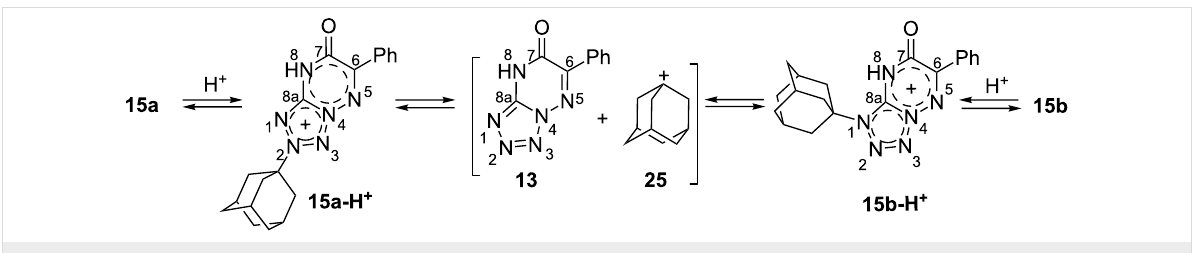
Scheme 5: Mechanism of the isomerization of compounds 15a and 15b